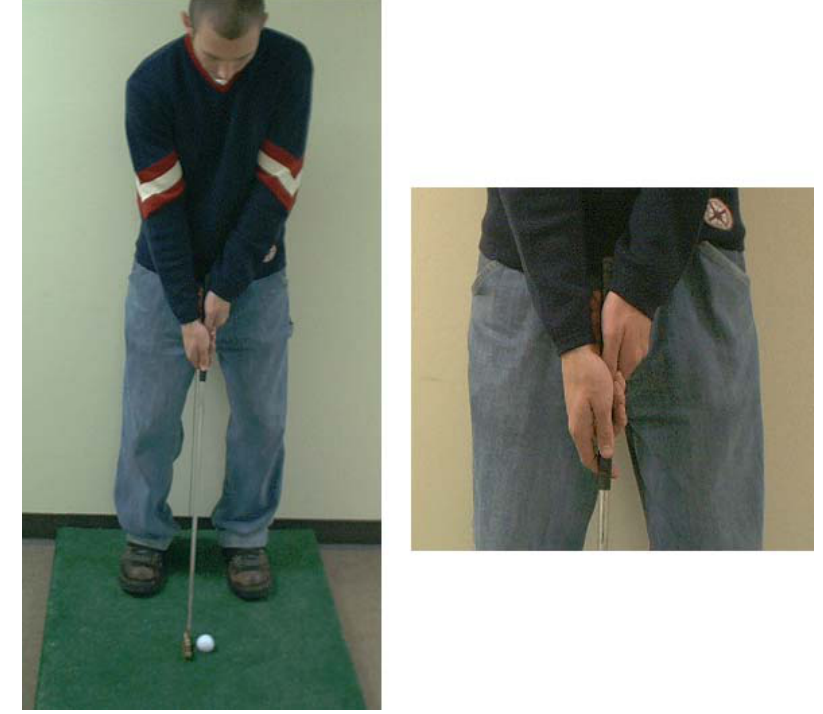
FIGURE 6 . (A) Overall view of conventional grip for putting in a novice player (GH), where the right hand is below the left hand. (B) Close-up view of the conventional